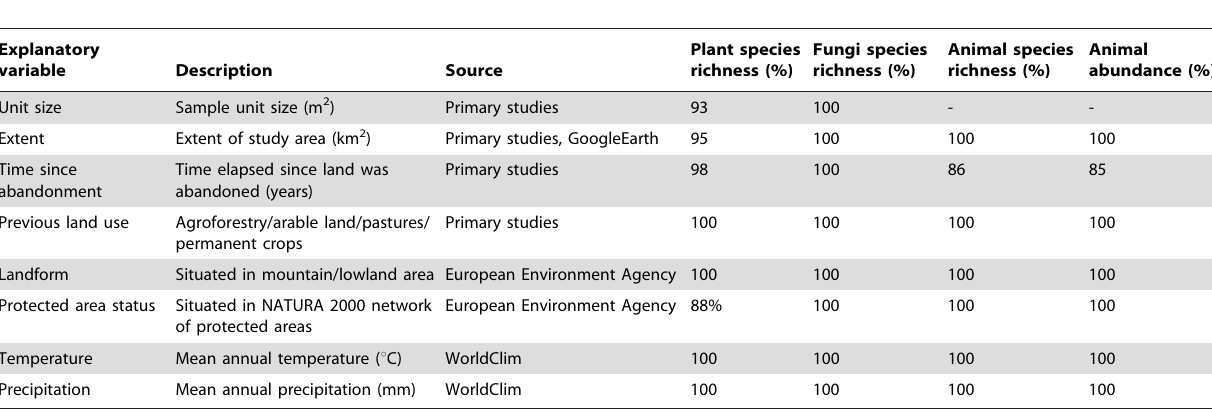
Table 1. Explanatory variables provided by primary studies and additional data sources that were included in the meta-analysis and percentage of observations for which these data could be